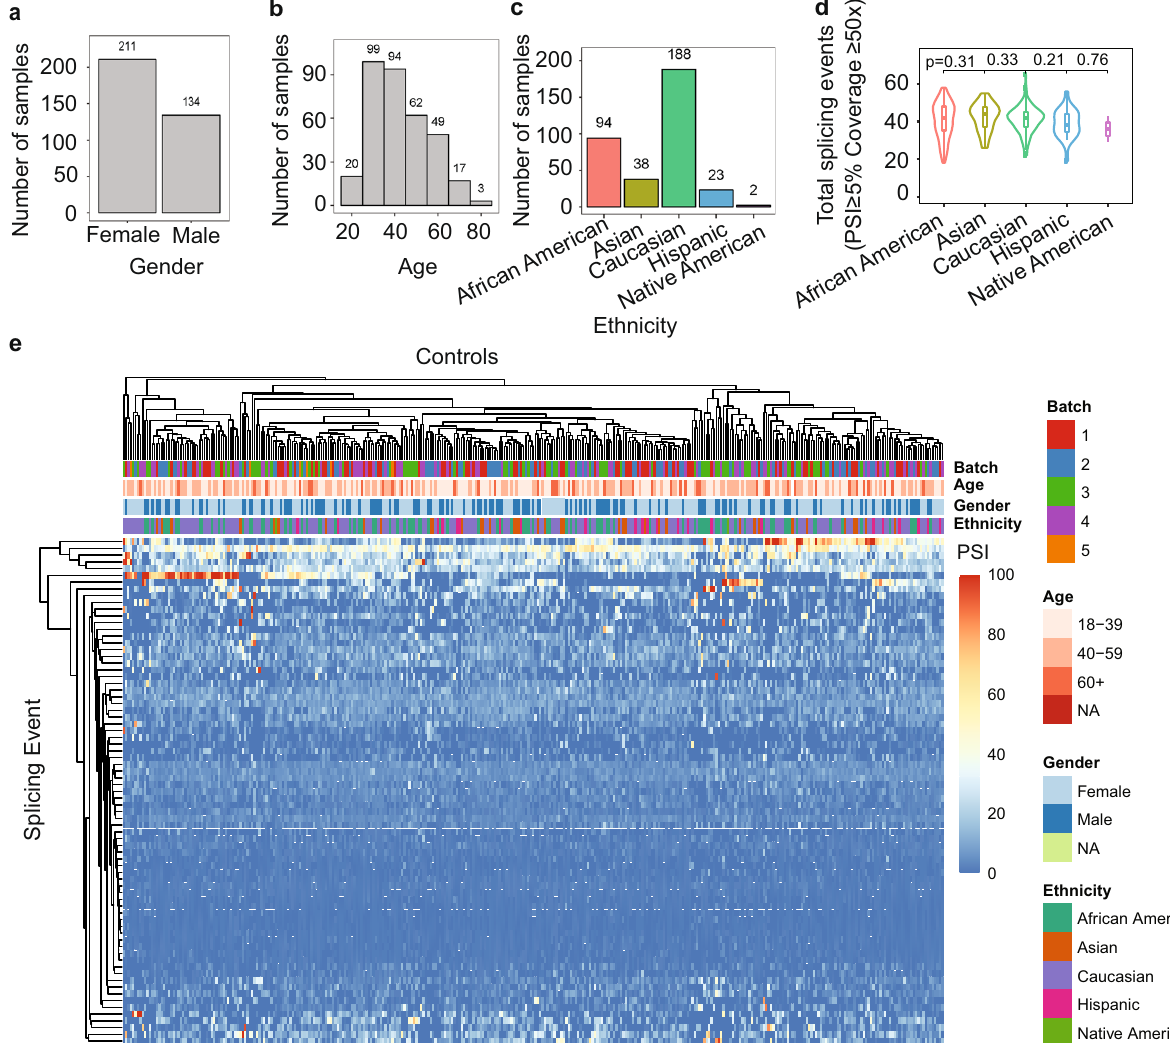
Fig. 1 Splicing landscape of 18 TSGs in healthy controls. a – c Histogram of control samples by ethnicity, age, and gender. d Violin plot indicating median number of splicing events detected at ≥ 5% PSI with coverage ≥ 50× for each reported ethnicity. T test p values between neighboring distributions are shown. All other pairwise t test p values were also non-signi fi cant (data not shown). e Hierarchical clustering of PSI for splicing events with PSI >1 in at least 150 individuals, assigning PSI to zero if no event was called. Samples (columns) are labeled by batch, age range, gender, and